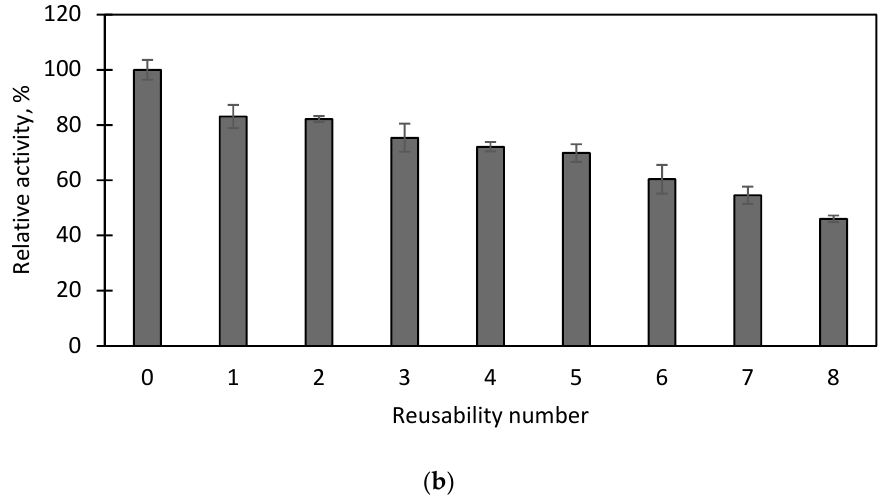
Figure 10. ( a ) Storage stability of free and immobilized EstD9; ( b ) reusability test of immobilized EstD9 for 8 assay cycles. The relative activity indicated the mean of standard deviation of triplicate assays ( n = 3).